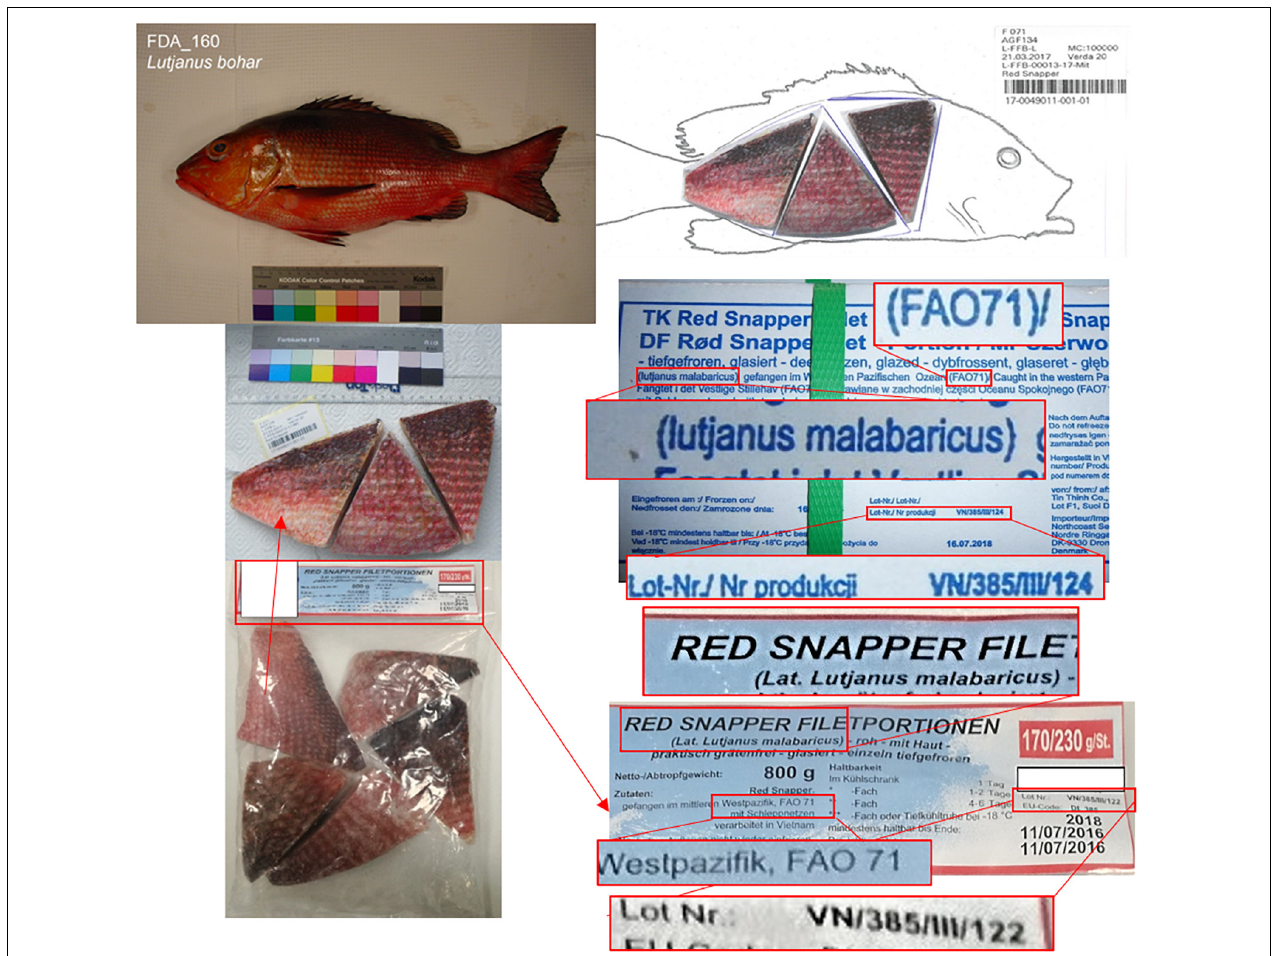
FIGURE 2 | Reference fish photo for L. bohar from the US Smithsonian National Fish Collection (USNMNH 395518) and US Food and Drug Administration reference standard sequence library for seafood identification, specimen ID (FDA 160) (Smithsonian National Fish Collection, 2021) (top left). Processed fish filets of the confiscated product (middle and bottom left)and the purported filet source from the whole fish (top right), relevant trace-back information were obtained from the boxes and packaging of the product (bottom right). Highlighted information includes catch region [Food and Agricultural Organization of the United Nations (FAO) zone 71], lot numbers VN/385/III/122 and 124, and marketed species name on the packaging. Samples from both lots were investigated by DNA barcoding for species authentication and CTX analysis (see sections “DNA-barcoding and labeling of the imported fishes,” “Evaluation of samples by in vitro cytotoxicity assay,” and “Evaluation of samples for ciguatoxins by liquid chromatography with tandem mass spectrometry